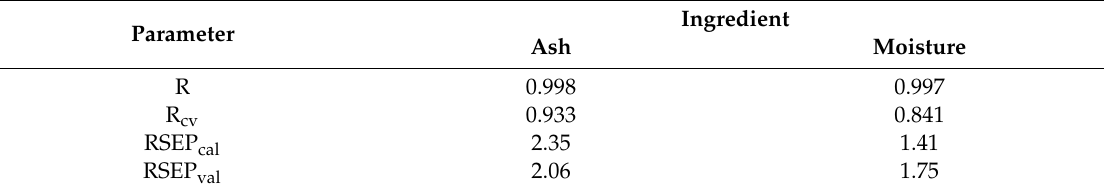
Table 1. Calibration parameters of the PLS models for ash and moisture determination.